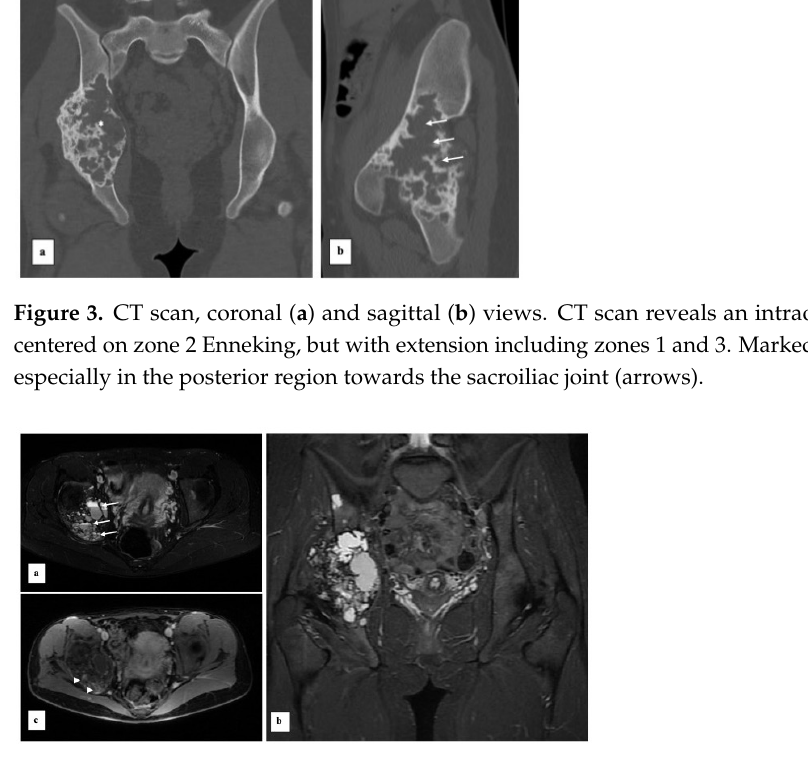
Figure 4. MRI axial ( a , c ) and coronal ( b ) views. T2 FS ( a ), STIR ( b ) and T1+k ( c ) sequences. MRI reveals an intraosseous heterogeneous mass. No adjacent bone marrow or soft tissue oedema. Rel- atively important cystic component with fluid-fluid level (arrows). Small solid components with moderate contrast enhancement